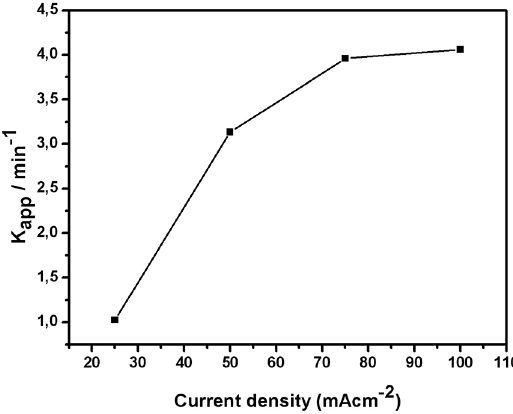
Figure 8. Kinetic constant variation from RO16 azo-dye electrodegradation process as a function of the applied current density.